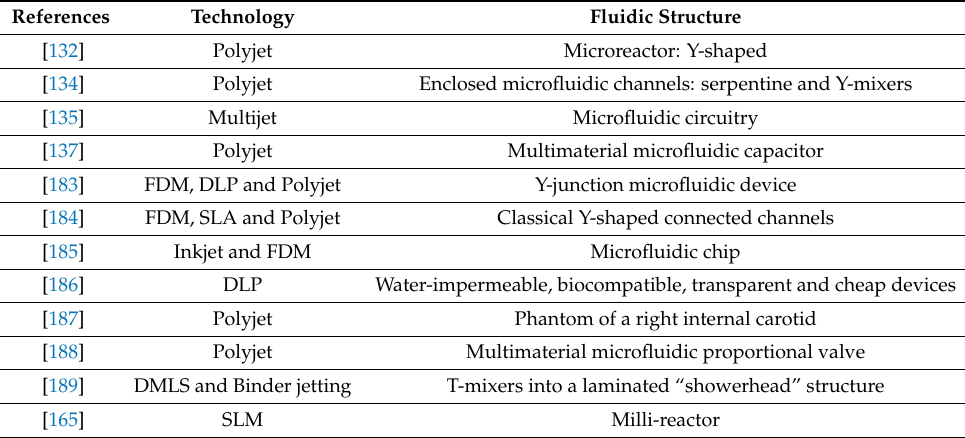
Table 3. Some examples of the application of AM technology in microfluidics.